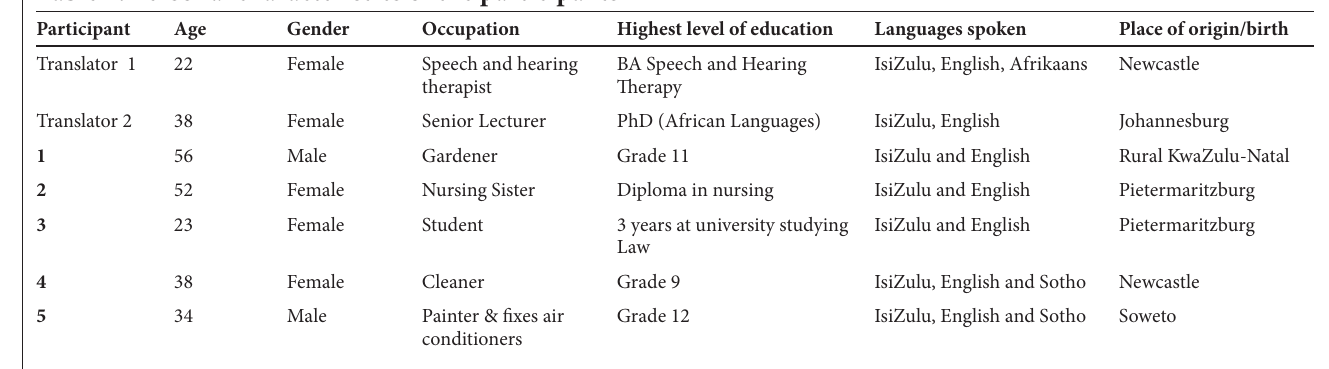
Table 1. Personal characteristics of the